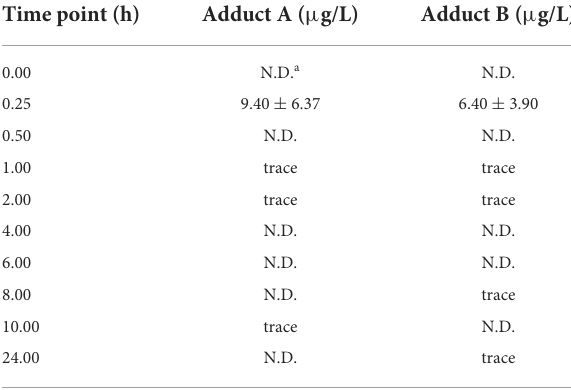
TABLE 3 Plasma concentration of adducts A and B in rats administrated with 100 mg/kg BW